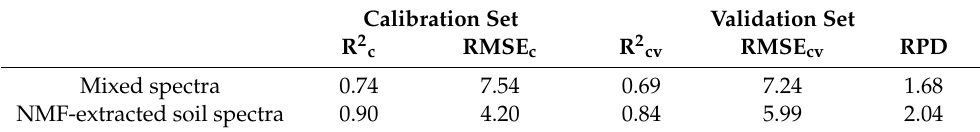
Table 3. Estimation accuracy of soil salt content with multiple